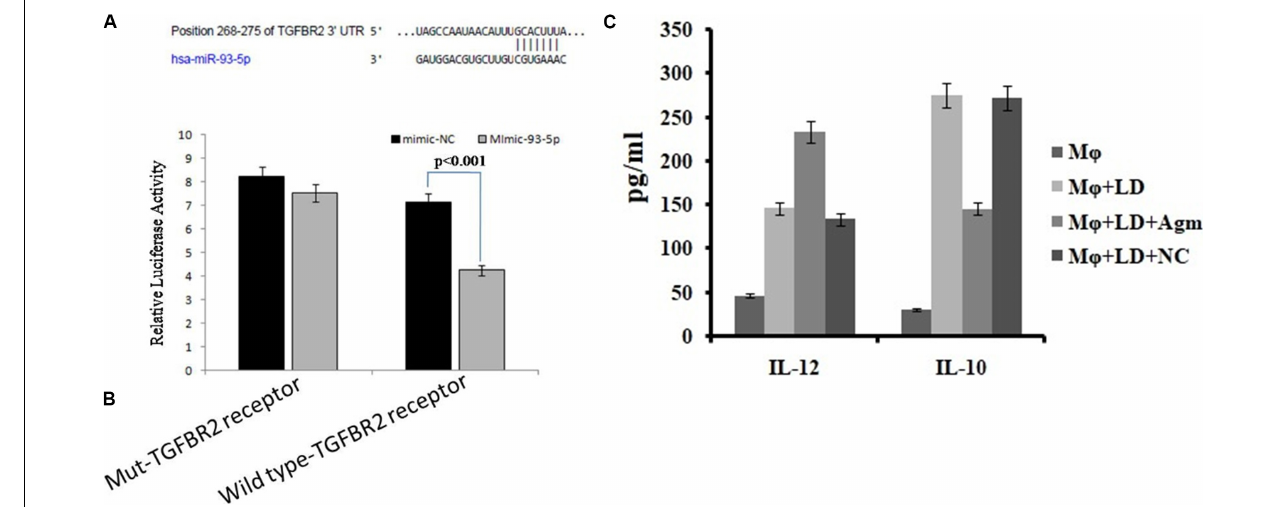
FIGURE 10 | Prediction and validation of TGFBR as target gene of miRNA-93-5p. (A) Schematic representation of miRNA-93-5p sequence bound to TGFBR receptor. The luciferase constructs fused to 30 untranslated regions (UTRs) (or Mut) of TGFB receptor were cotransfected in macrophages cells with mimic miRNA-93 or mimic-NC. The luciferase activities were expressed as the ratio of firefly luciferase over renilla luciferase. (B) The macrophages transfected with mimic of miRNA-93 significantly reduced the luciferase activities ( P < 0.001) of genes fused to the TGFB receptor family 30 UTR. (C) Effect of antagomir miRNA-93-5p in the activation of interleukin (IL)-10/IL-12 secretion from macrophages after